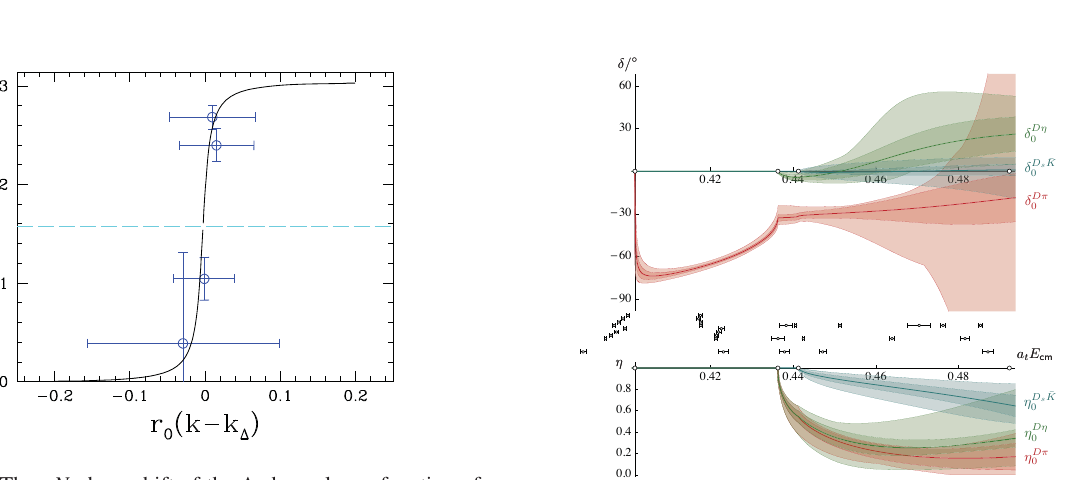
Figure 4. The π N phase shift of the Δ channel as a function of the center-of-mass momentum k . The solid line is the phase gen- erated from the physical mass and width of the Δ -resonance. The dashed horizontal line indicates the 90 ◦ crossing of the phase. used a N f = 2 clover action that consists of the plaque- tte gluon action together with nonperturbatively O ( a ) im- proved Wilson (clover) fermions on 32 3 × 64 and 40 3 × 64 lattices at β = 5 . 29 , κ = 0 . 13632 , a = 0 . 075 fm and on 40 3 × 64 and 48 3 × 64 lattices at β = 5 . 29 , κ = 0 . 1364 , a =